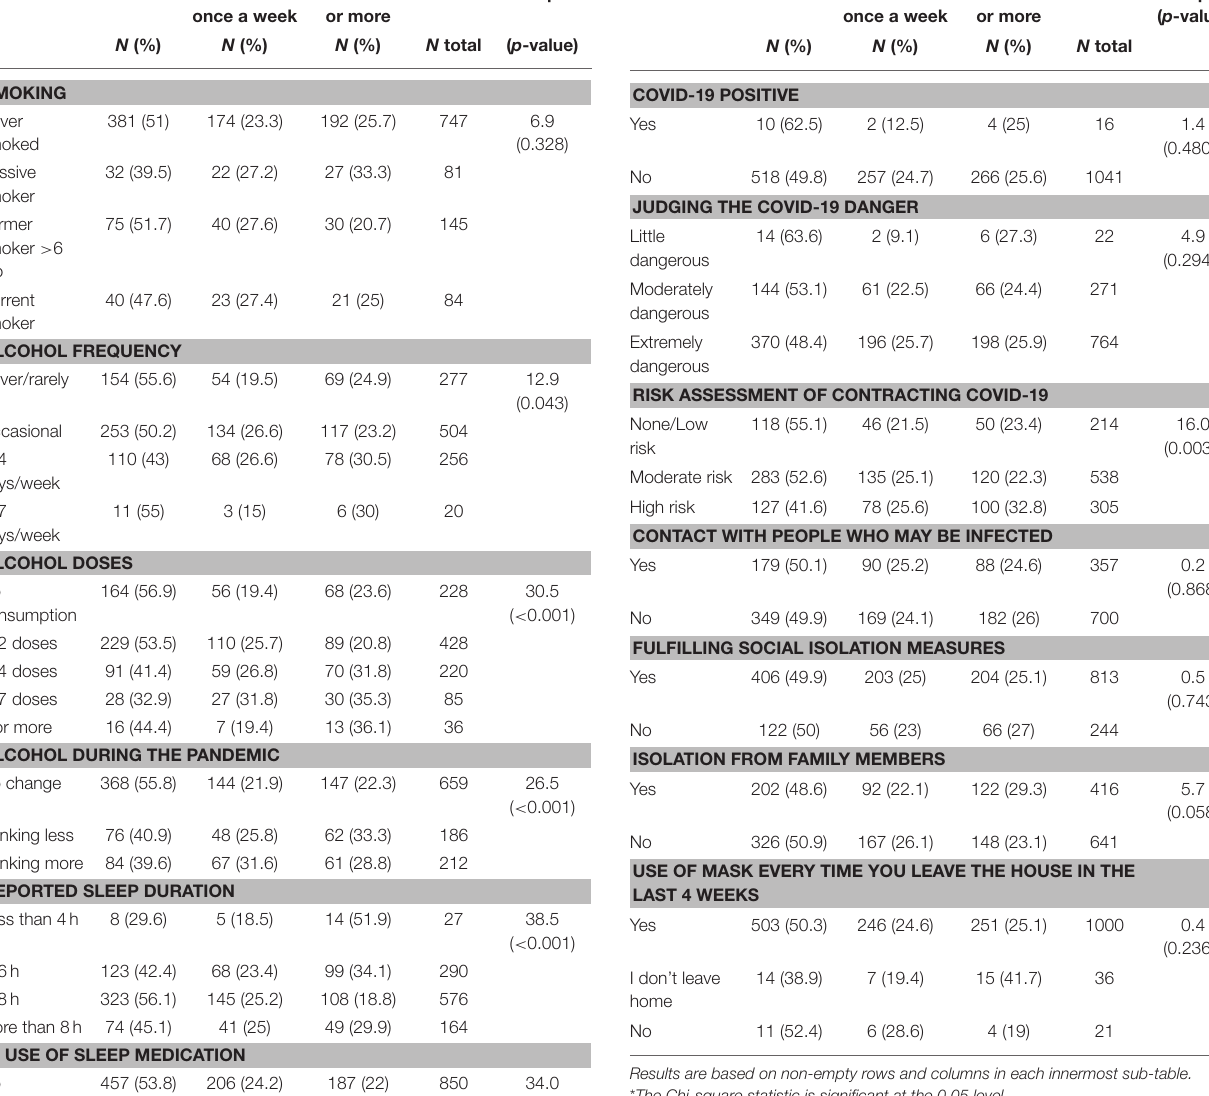
TABLE 4 | Nightmares during the pandemic by variables related to the COVID-19 TABLE 3 | Nightmares during the pandemic by health-risk behaviors and clinical pandemic. antecedents ( N = 1,057). None Less than Once a week Chi-square None Less than Once a week Chi-square once a week or more once a week or more ( p